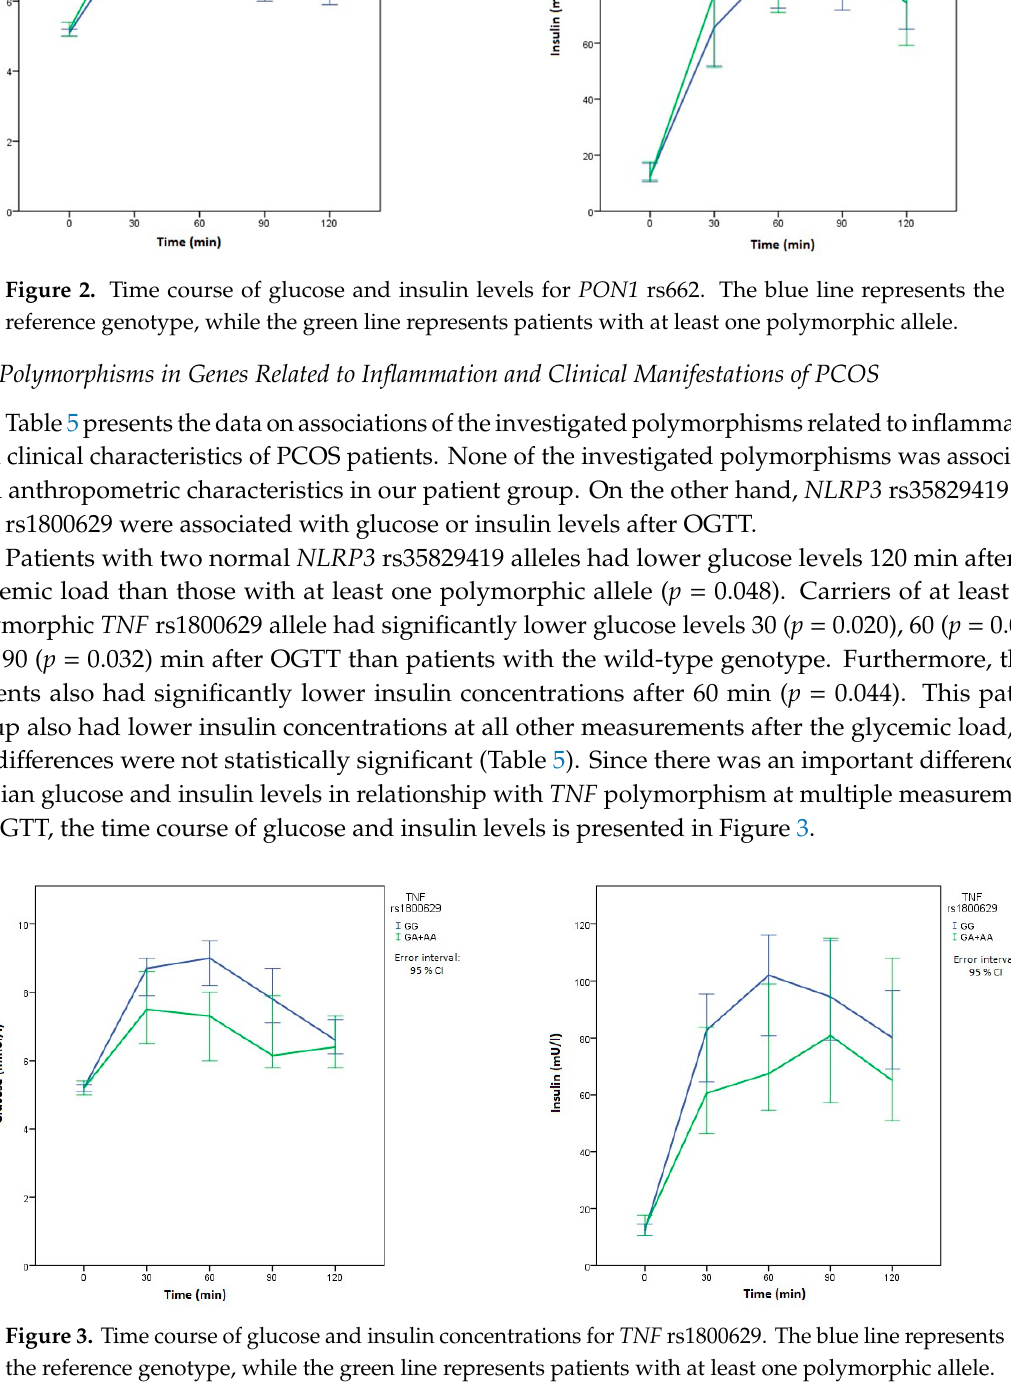
Figure 1. Time course of glucose and insulin levels for PON1 rs854560. The blue line represents the reference genotype, while the green line represents patients with at least one polymorphic allele.